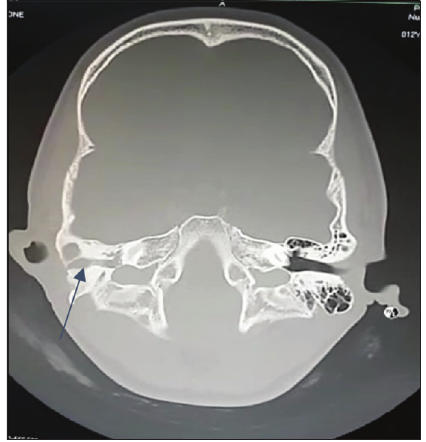
FIGURE 1. Axial view of the high-resolution computed tomography temporal showed the right narrowed bony canal causing canal stenosis (arrow).